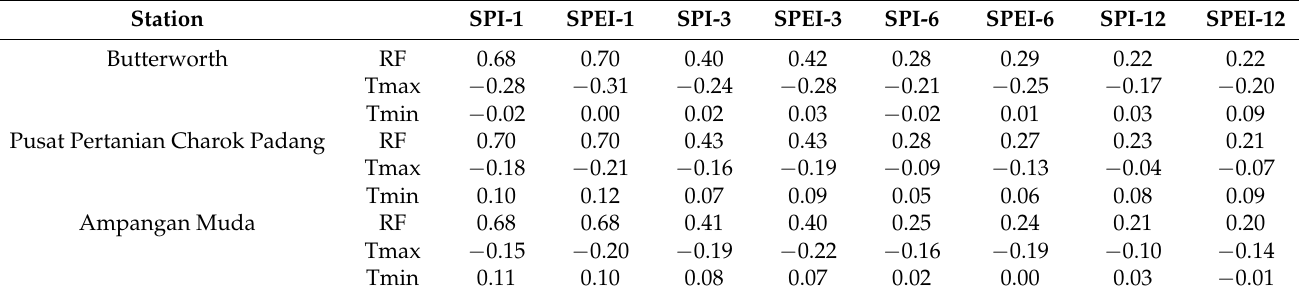
Table 8. Correlation of the SPI and SPEI with rainfall and maximum and minimum temperatures at 1-, 3-, 6-, and 12-month